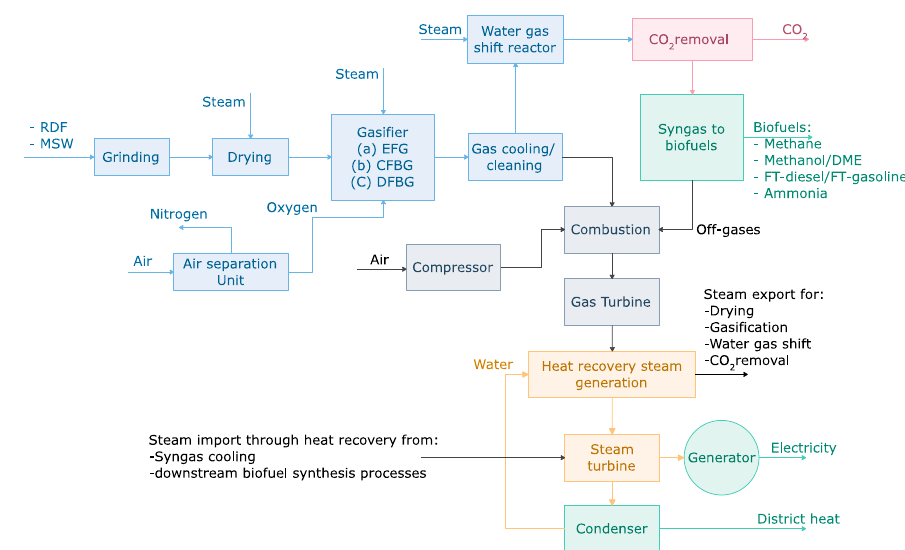
Figure 1. Simplified process flow diagram of a waste-based polygeneration facility. Two types of feed—RDF and MSW—are considered and three different gasifiers—EFG, CFBG, and DFBG—are evaluated.